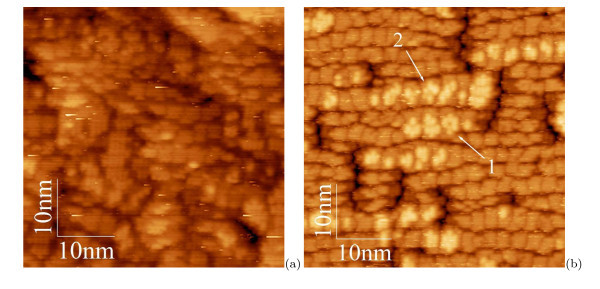
STM images of Ge WL on Si(001): (a) before cluster nucleation, hGe = 4.4 Å (Us = -1.86 V, It = 100 pA); (b) arising nuclei of pyramidal (1) and wedgelike (2) huts, hGe = 5.1 Å (Us = +1.73 V, It = 150 pA).